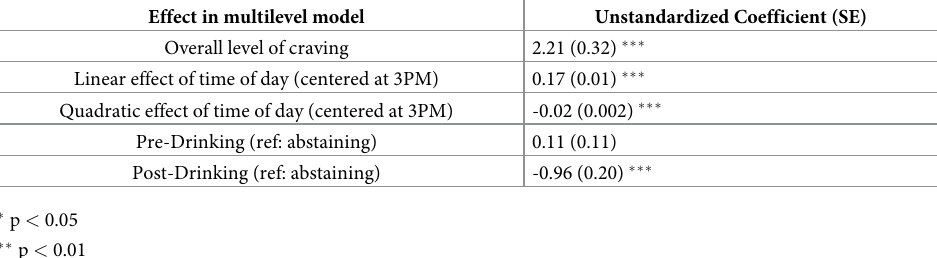
Table 2. Results of growth curve analyses examining the effects of time of day (linear & quadratic trends) and hav- ing a drink on reported craving for alcohol. Effect in multilevel